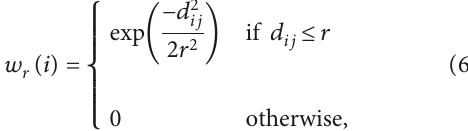
( e ) , the estimated value of the grid r 1 is not 3